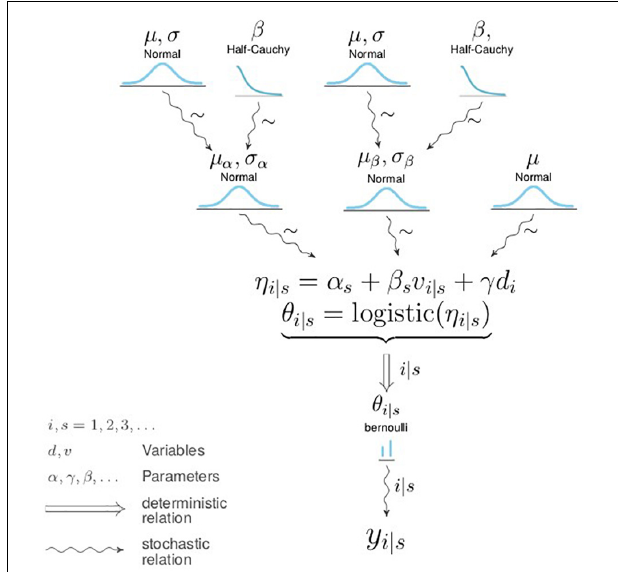
FIGURE 1 | Diagram showing the full Bayesian hierarchical